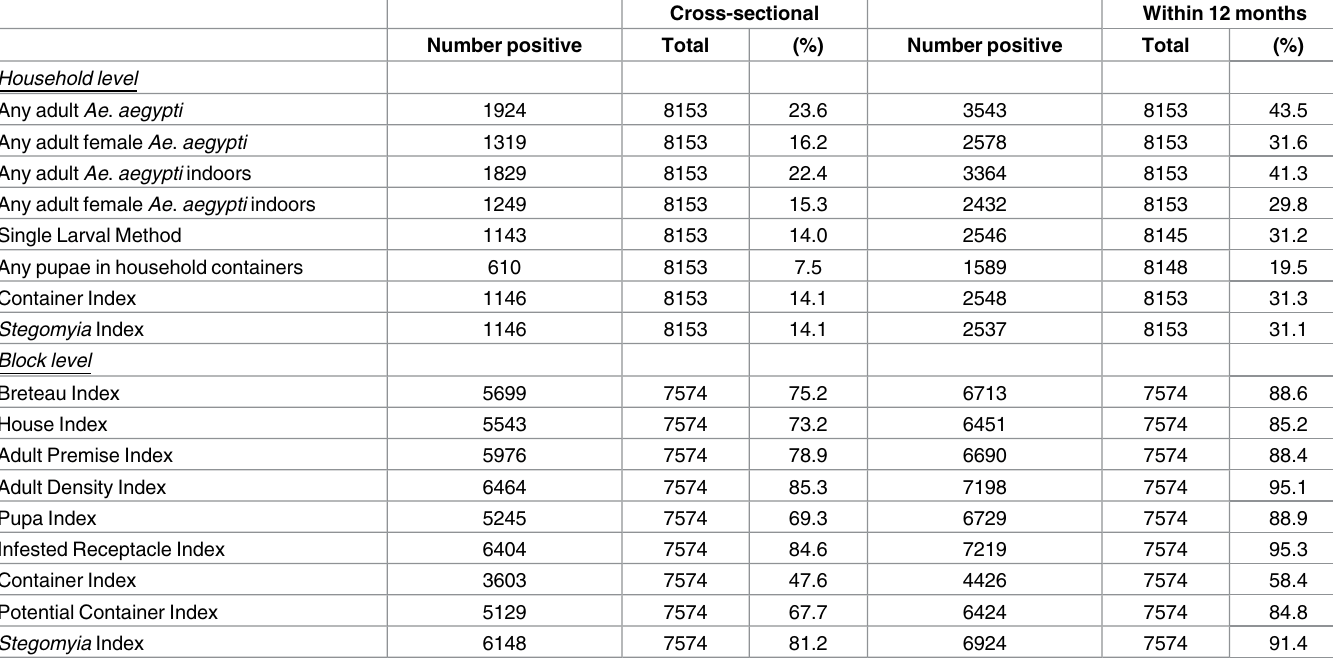
Table 4. Distribution of categorical indicators for serological